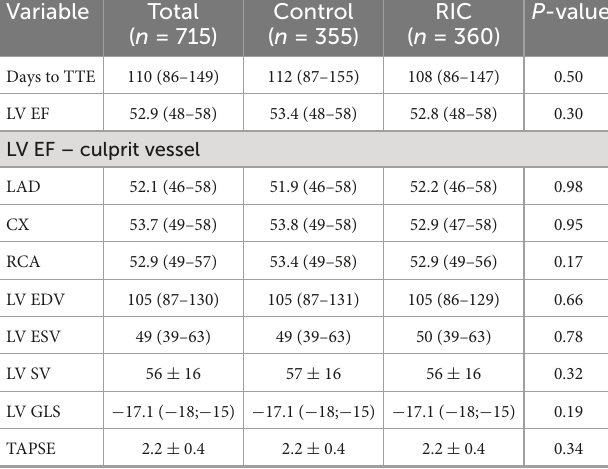
FIGURE1 Left ventricular ejection fraction stratified by culprit vessel. LAD, left anterior descending artery; CX, circumflex artery; RCA, right coronary artery; RIC, remote ischaemic